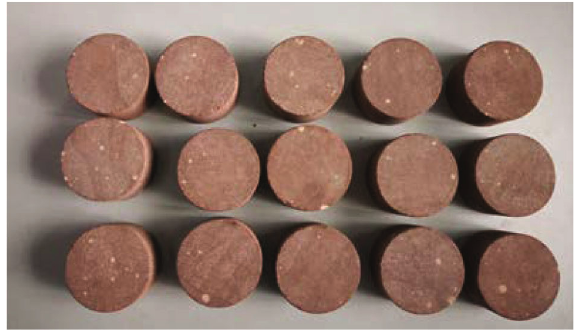
Figure 1: Red sandstone